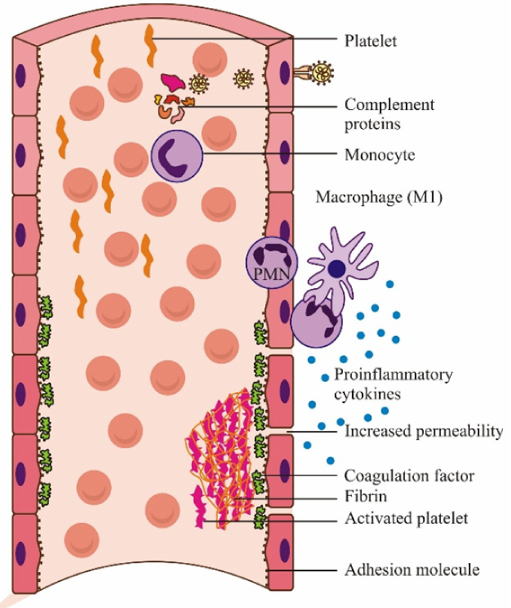
Figure 2. The interrelation between inflammatory and coagulation cascades in the SARS-CoV-2 infectious process. The inflammatory response increases vascular permeability and activates the complement macrophages and procoagulation phenotypes of platelets and endothelial cells, leading to endothelial lesions (reconstructed after Aid et al., 2020